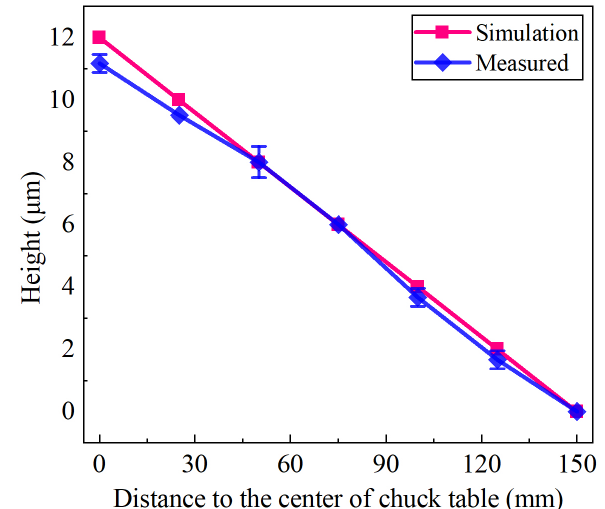
Figure 15. The comparison between the experimental and simulation results of the chuck table shape after dressing